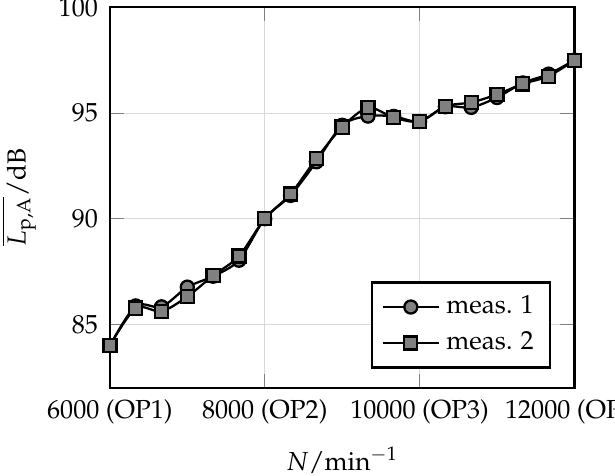
Figure 9. A weighted OSPL of unmodified EDF unit over the operating